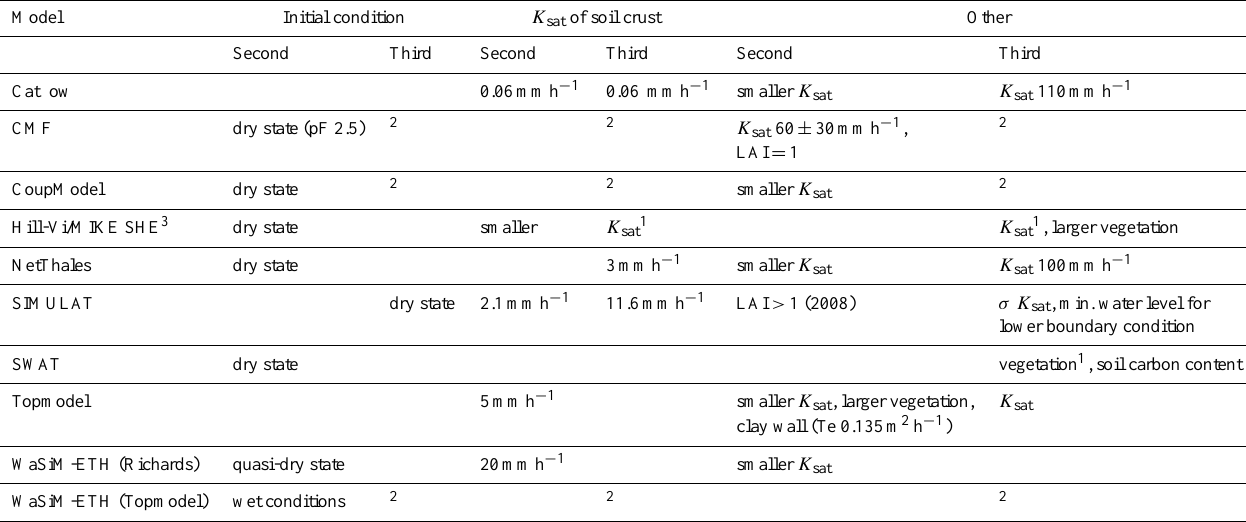
Table 4. Major modifications in the parameterization between the first to second and second to third prediction.